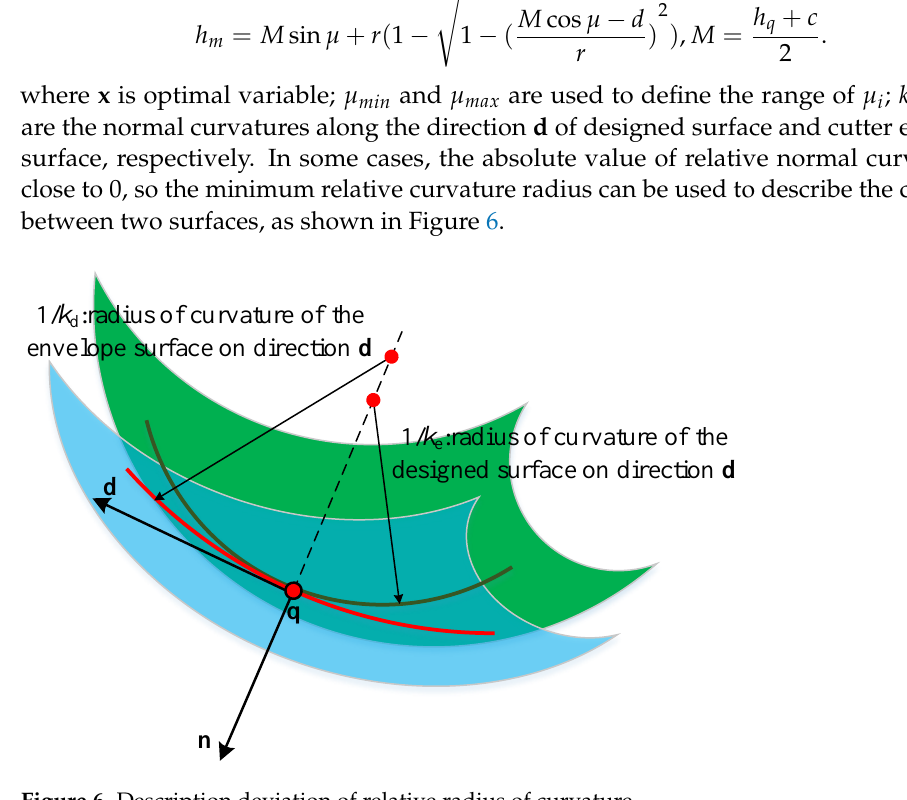
Figure 6. Description deviation of relative radius of